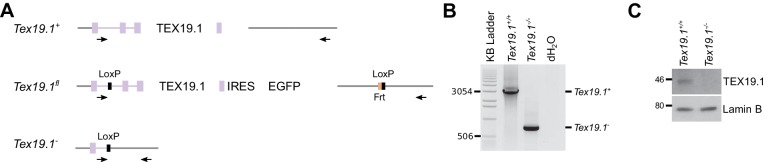
Generation and validation of Tex19.1−/−
ESCs.(A) Schematic diagram showing the Tex19.1
alleles generated in ESCs. The Tex19.1 locus is shown in
purple, flanking DNA in grey. Introns are shown as lines, exons as
rectangles, and the coding region as large rectangles. LoxP sites (black)
and an internal ribosome entry site (IRES, blue) coupled to enhanced
green fluorescent protein (EGFP, green) were introduced into the locus to
generate a Tex19.1fl allele. This allele also
contains an Frt site (orange) left over after excision of a neomycin
resistance cassette. After treatment with Cre recombinase the entire
Tex19.1 coding sequence is removed from the
Tex19.1fl allele to generate
Tex19.1-. Arrows indicate position of
genotyping primers used in panel B. (B) PCR genotyping of
Tex19.1−/− ESCs. Genomic DNA from
Tex19.1+/+ ESCs,
Tex19.1−/− ESCs or distilled water
(dH2O) was used as a template for genotyping PCR using the primers shown
in panel A. Migration of selected bands in the KB ladder (Invitrogen) is
indicated. (C) Western blot for TEX19.1 and lamin B in
Tex19.1+/+ and
Tex19.1−/− ESCs. MW markers (kD) are
indicated.